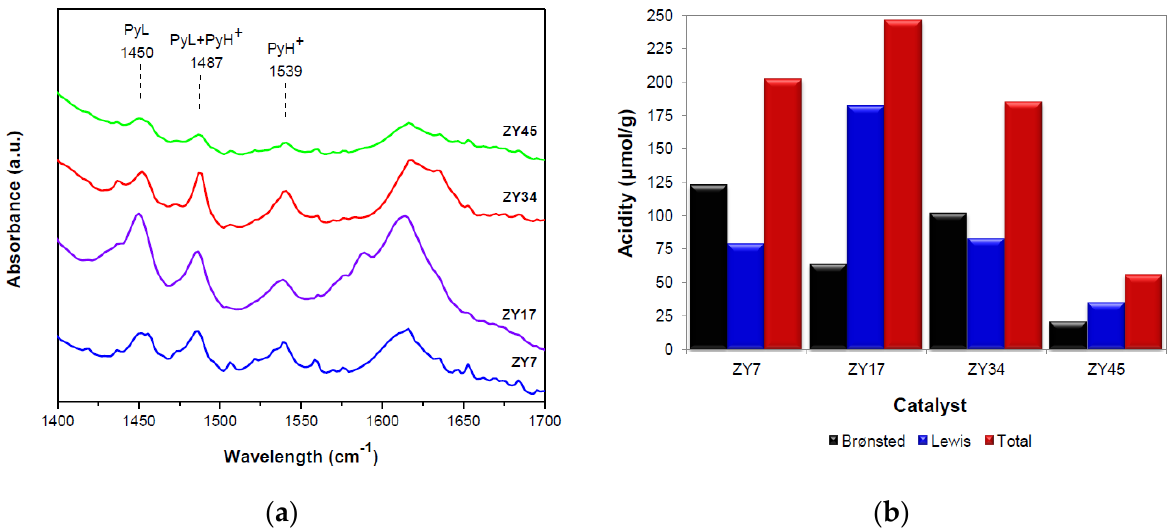
Figure 3. ( a ) Infrared spectra with adsorbed pyridine, and ( b ) quantification of the Brønsted and Lewis acid sites of the Y-type zeolites at 350 °C.